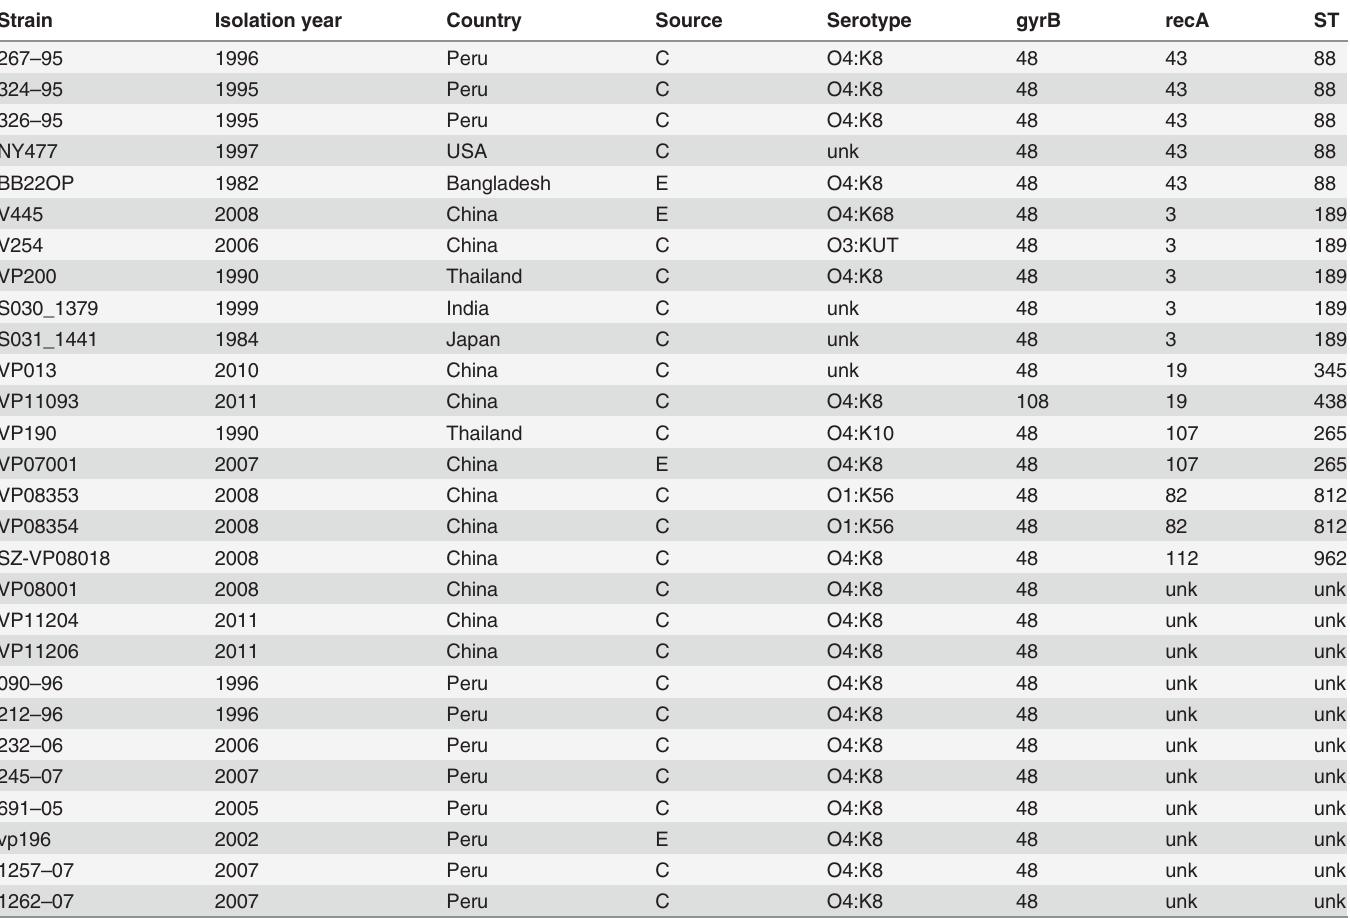
Table 2. V . parahaemolyticus strains with similar allele types to strain 090 – 96 available at the MLST V . parahaemolyticus database.